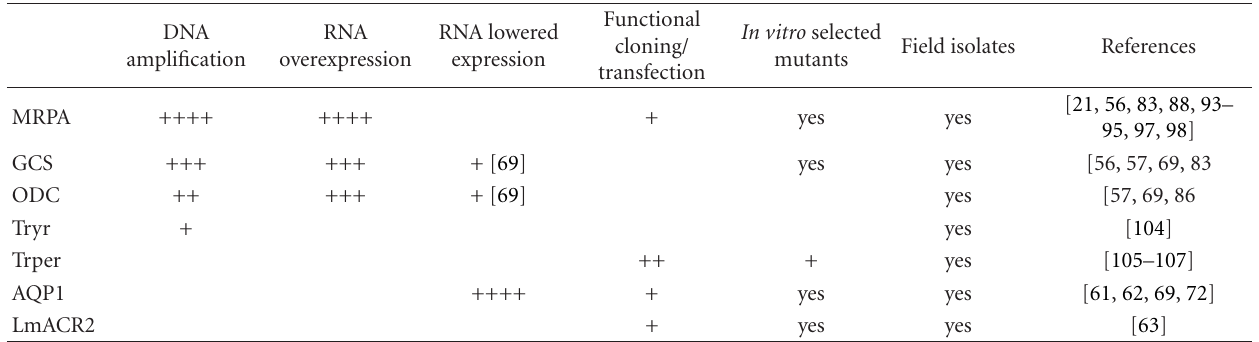
Table 1: Relevant molecular targets involved in Leishmania antimony resistance.